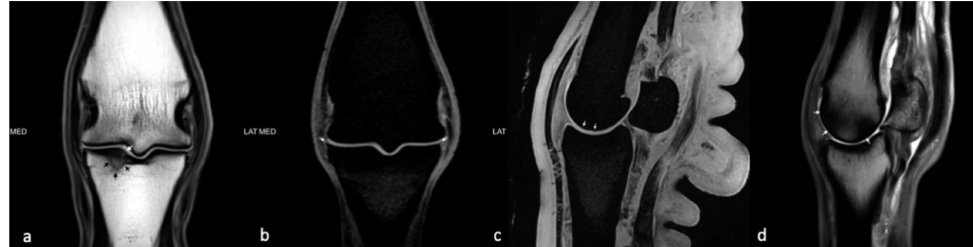
Figure 2. Image panel representative of some of the MRI findings from the study. ( a ) Dorsal plane T1W TSE image at the mid aspect of the metacarpophalangeal joint of horse #7 showing a fissure within the subchondral bone plate of the proximal phalanx along the medial aspect of the sagittal groove ( white arrows ) that is surrounded by sclerosis and intra-osseous fluid accumulation (black arrows). ( b ) Dorsal plane T1W VIBE image of horse #9 near the dorsal aspect of the metacarpophalangeal joint showing osteophytes arising from the dorsal, proximal, abaxial margins of the proximal phalanx ( white arrows ). ( c ) Sagittal plane T1W VIBE image at the mid aspect of the medial third metacarpal condyle showing irregularity of the subchondral bone plate of the third metacarpus and signal alteration of the overlying articular cartilage ( white arrows ). ( d ) Sagittal plane PDW TSE image of the medial aspect of the third metacarpal condyle showing regions of low signal bone intensity of the dorsal and palmar aspects of the condyle as indicated by the white arrows.